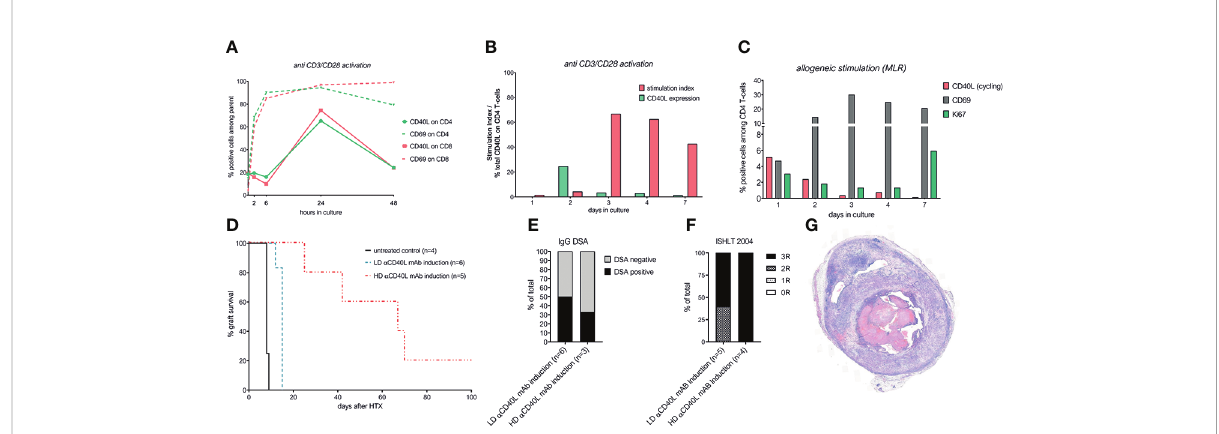
FIGURE 1 CD40L is upregulated early upon stimulation in-vitro , but its in-vivo blockade as induction alone does not facilitate long term cardiac allograft survival. (A) CD40L and CD69 surface expression on CD3 + CD4 + and CD3 + CD8 + T cells at indicated time points after stimulation with anti-CD3 and anti-CD28 mAb. (B) CD40L expression and stimulation index for CD3 + CD4 + cells during activation with a CD3/ a CD28 mAb. Stimulation index was de fi ned as: %CFSE dim cells within stimulated cells/%CFSE dim cells within unstimulated control cells. (C) Mixed lymphocyte reaction of 0.5x10 6 C57BL/6 splenocytes incubated with 0.5x10 6 irradiated Balb/c splenocytes. CD69 and Ki67 are gated on CD3 + CD4 + T-cells, CD40L expression on activated (CD69 + ) T-cells. (D) Cardiac allograft survival of untreated mice (n=4, black line), mice receiving low-dose a CD40L mAb induction (n=6, yellow dotted line) and mice receiving high-dose a CD40L mAb induction (n=5, 0.5mg; red dotted line). (E) Percentage of mice with detectable donor speci fi c IgG antibodies at the time of rejection or end of long-term follow-up. In mice treated with HD a